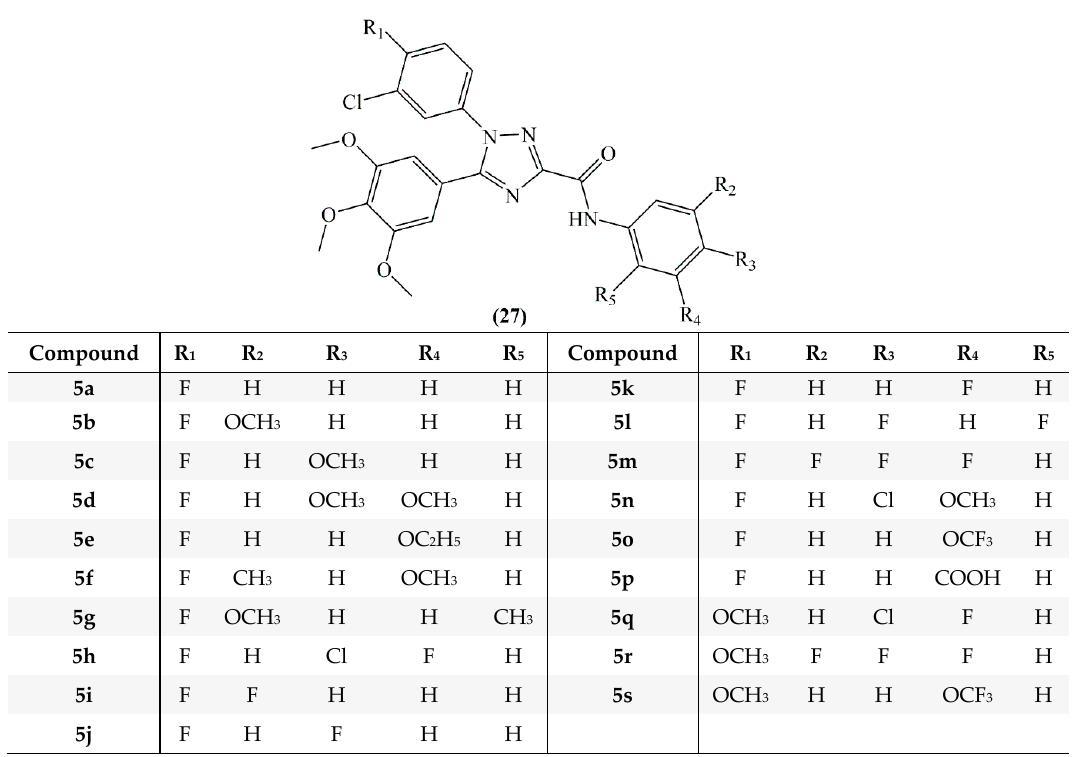
Figure 14. Structure of 1,2,4-triazole-3-carboxamide analogs of combretastatin.